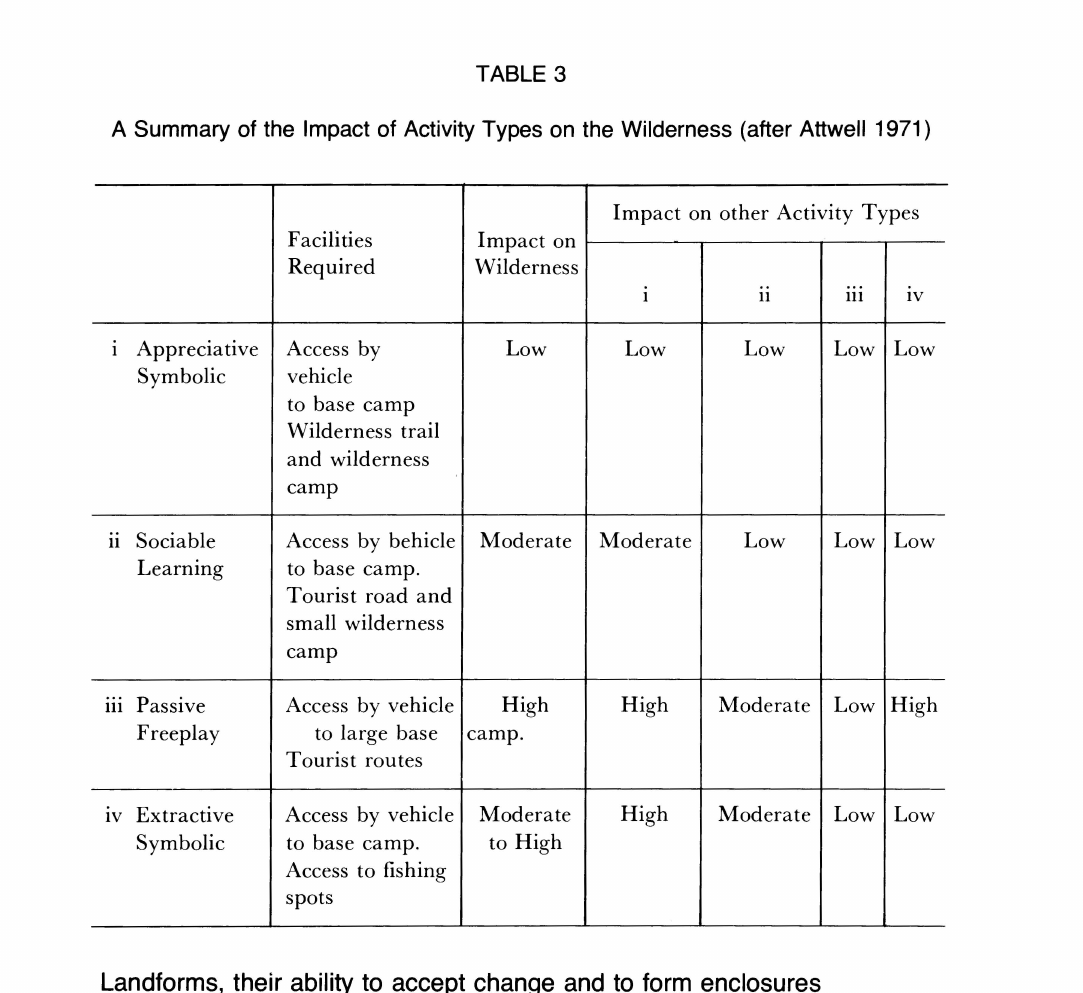
Impact on other Activity